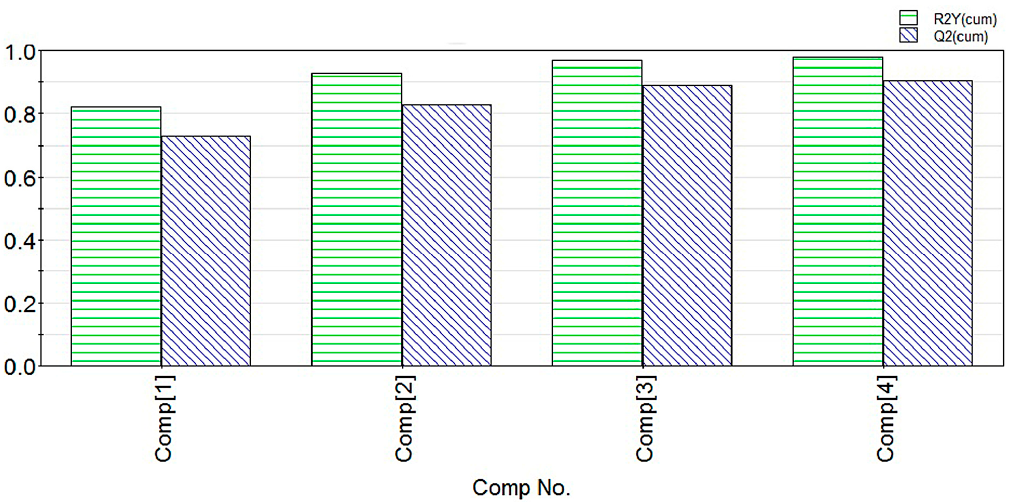
Figure 9. R 2 and Q 2 parameters compared with 1 – 4 components extracted.